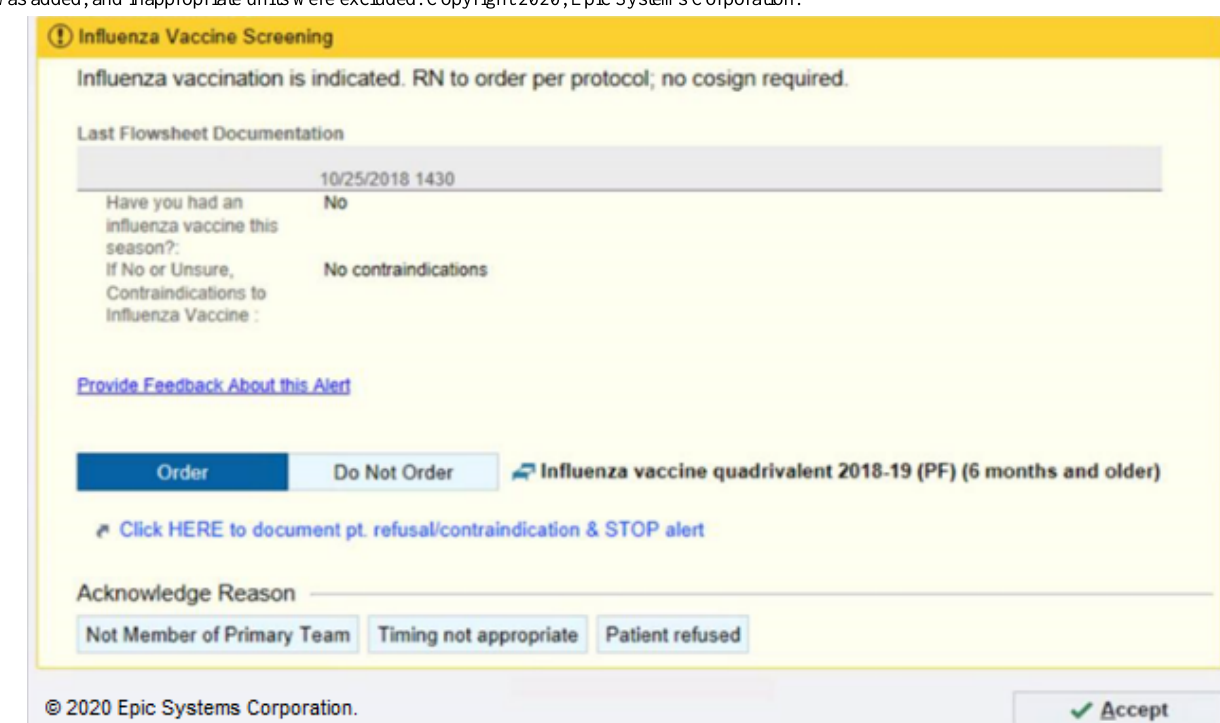
Vaccination compliance rate at discharge, % P valueFirings per pa-